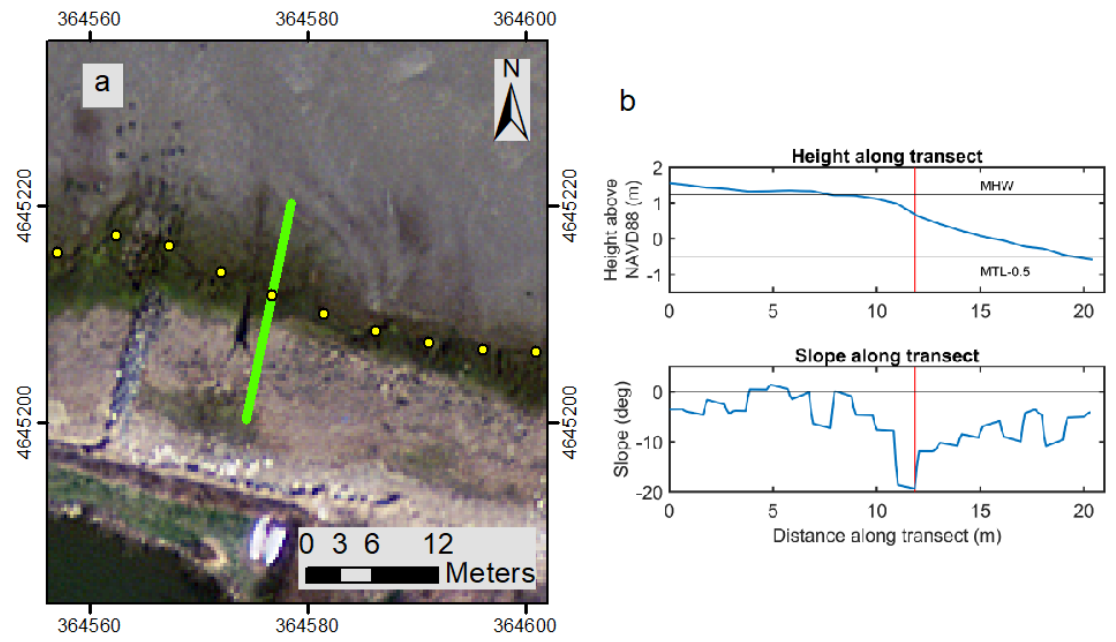
Figure 5. ( a ) Plymouth, MA, USGS imagery. Yellow dots: Marsh scarp from MEED, green line: Sample transect; ( b ) lidar elevation data from transect shown in Figure 5a. The vertical red line is the calculated marsh scarp. Top: Elevation along transect, the horizontal black lines indicate MHW and (MTL - 0.5 meters). Bottom: Slope along transect.